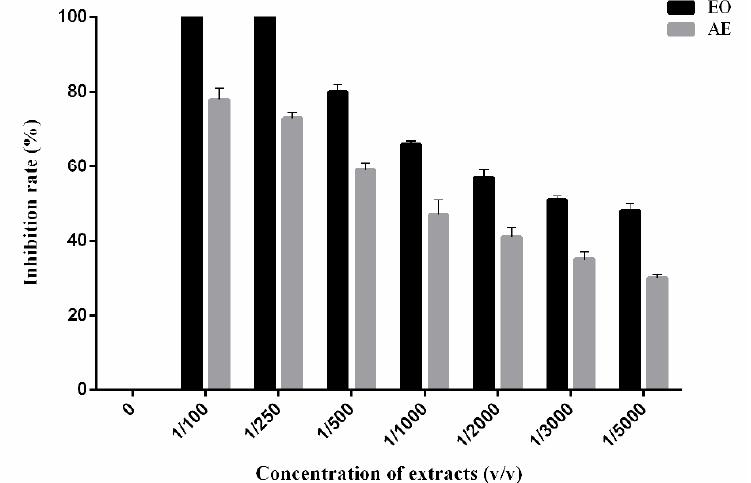
Figure 1. Inhibition rate of F. oxysporum against the different concentrations of L. angustifolia extracts Evaluation of antioxidant activity of L. angustifolia